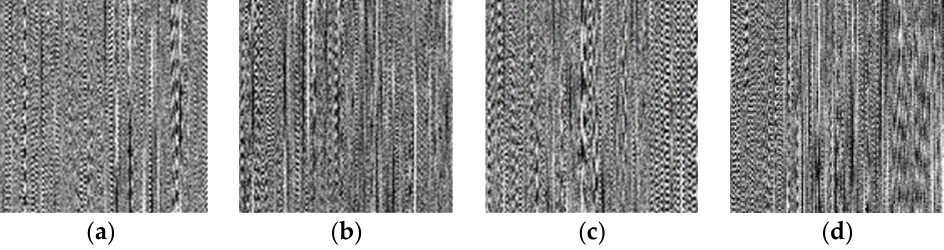
Figure 17. Grayscale image after adding noise. ( a ) Switch; ( b ) Seam; ( c ) Damage; ( d ) Normal.